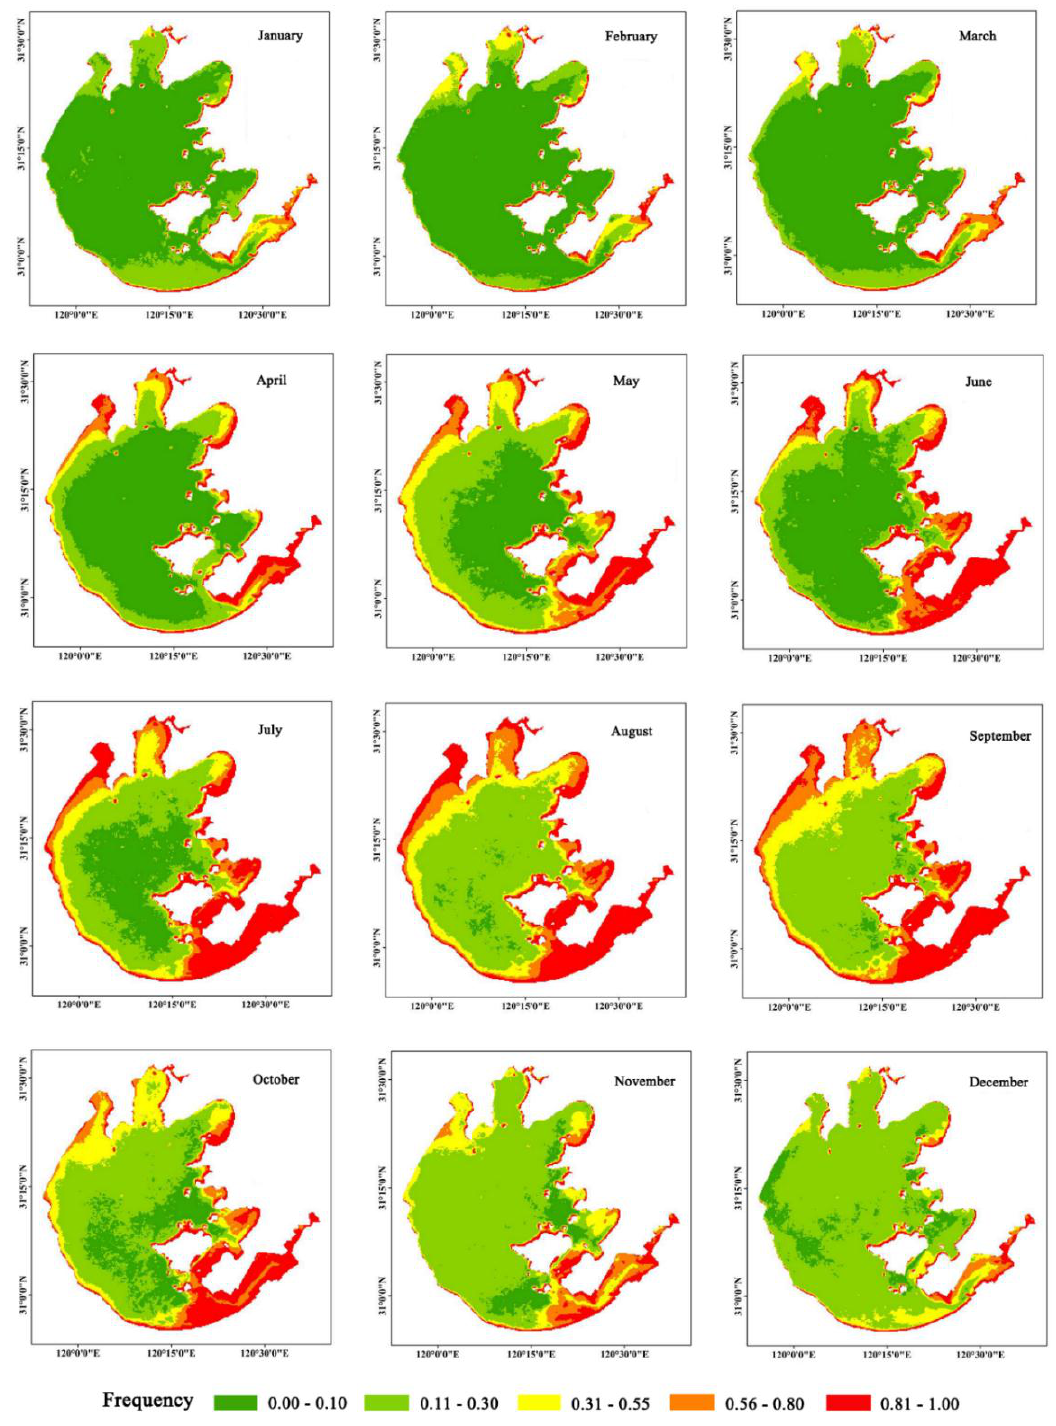
Figure 6. MODIS-Aqua-derived (2003–2013) monthly climatology Floating Algae Index